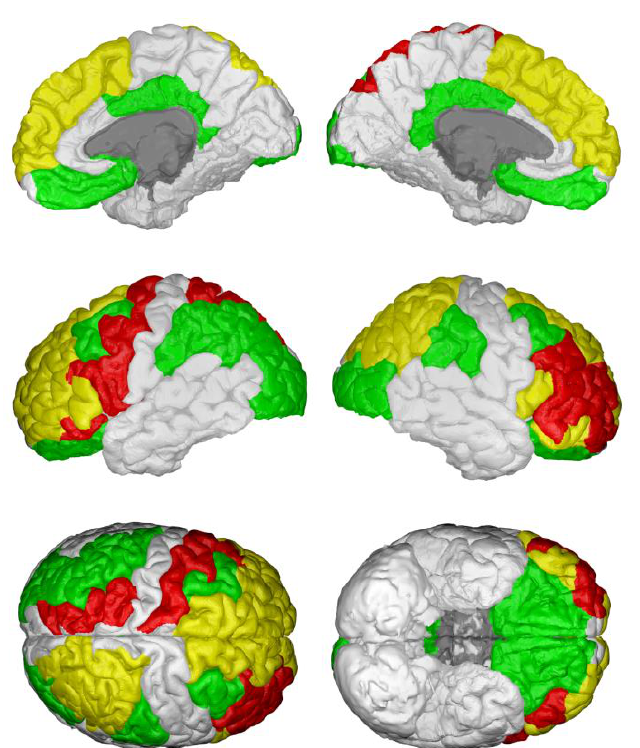
Figure 2. Cortical areas involved in delay discounting. A qualitative reconstruction was obtained using the Desikan – Killiany cortical atlas and BrainPainter [67] to summarize the areas involved in delay discounting determined by neuroimaging studies (green areas) and non-invasive brain imaging (NIBS; red areas); yellow areas indicate the overlap between the two.